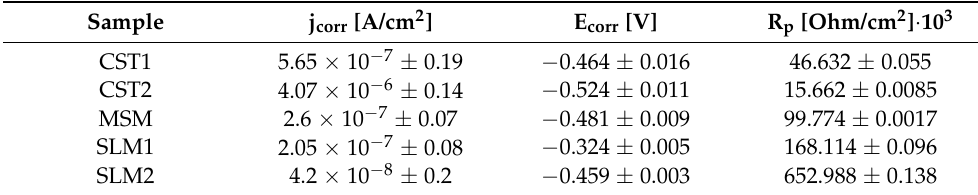
Table 5. The corrosion parameters obtained for the examined alloys in 0.9% NaCl solution with reference to the saturated calomel electrode (SCE) in potential range from − 1 to 2 V.